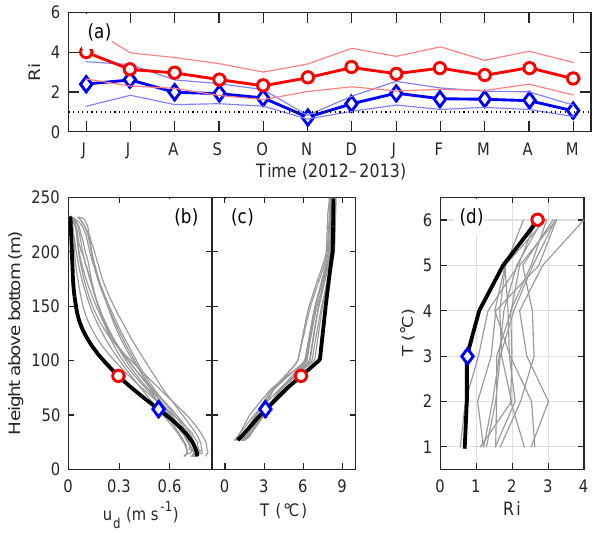
Figure 14. Same as Fig. 13 but for mooring S2, on the slope.